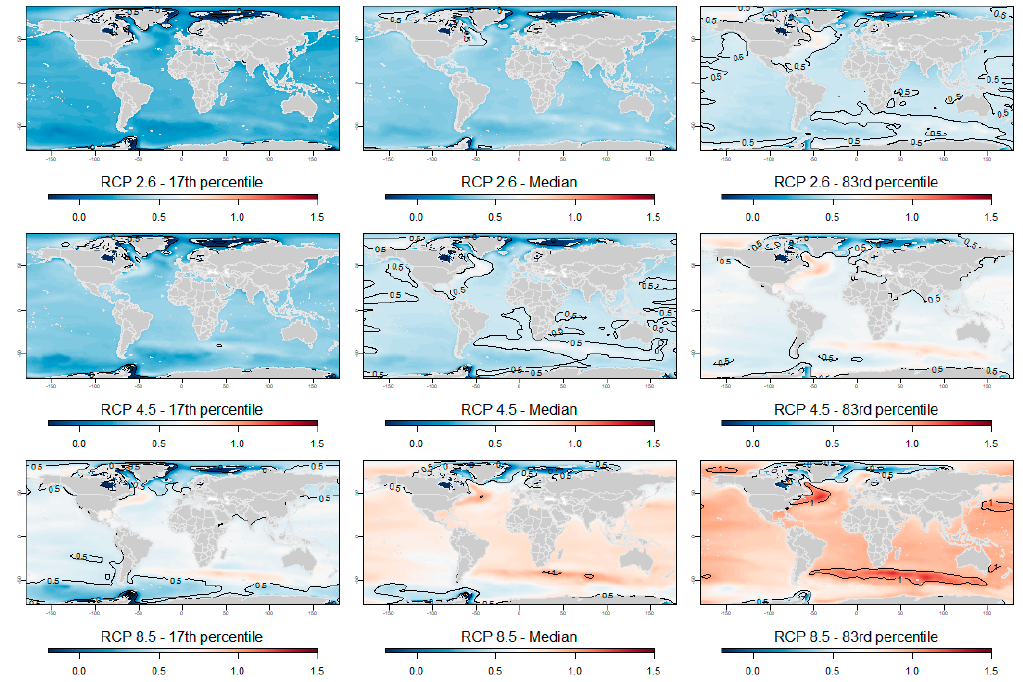
Figure 6. Regional low-end sea-level scenarios in 2100 for the RCP2.6, 4.5, and 8.5 scenarios (unit: m).